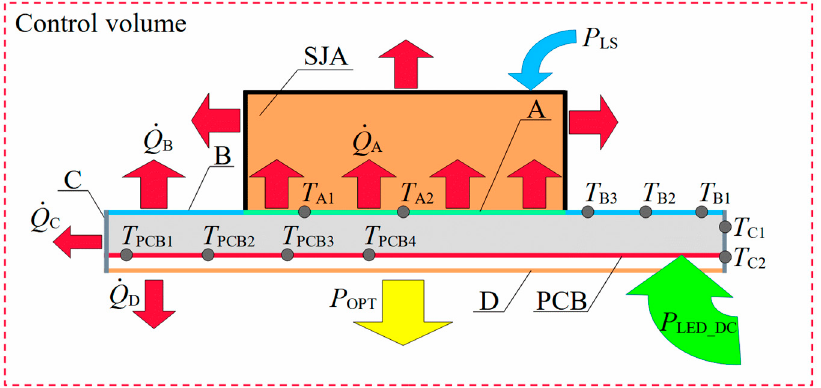
Figure 3. The characteristic surfaces and points of the characteristic temperature measurements at the LED lamp.